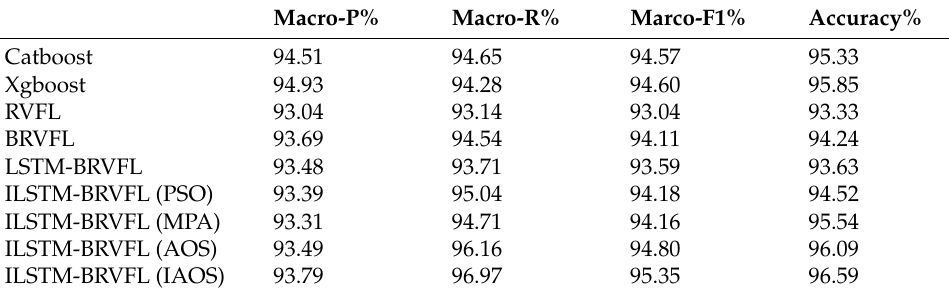
Table 7. Evaluation indicators of the contrast model on w 3